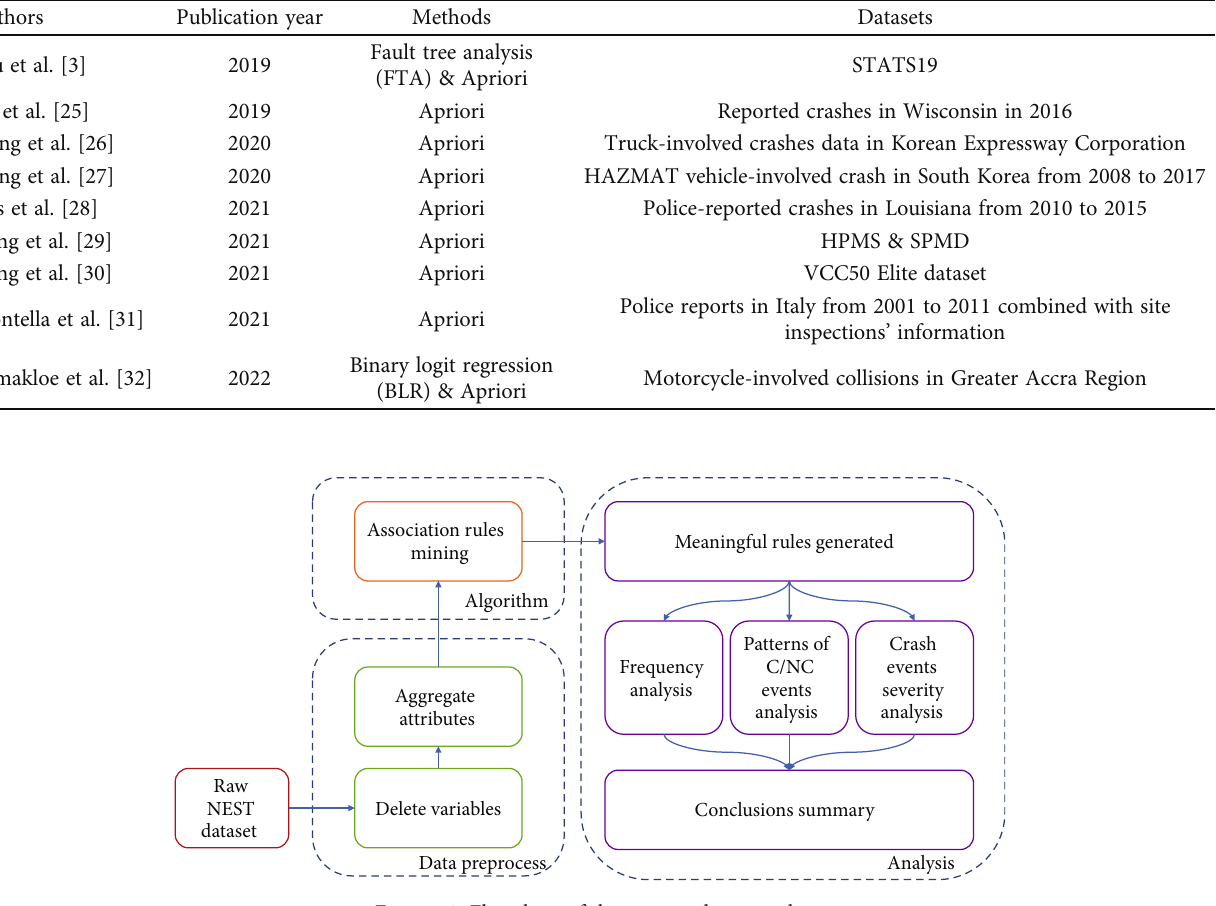
Table 1: Summary of ARM applications for crash analysis.